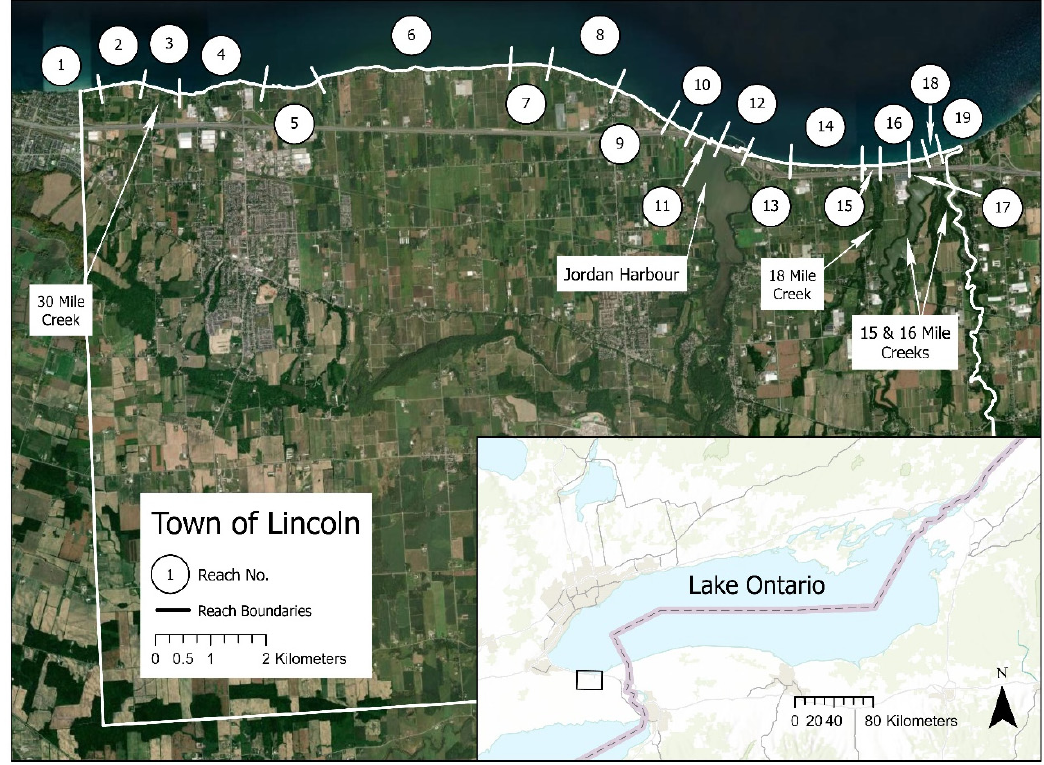
Figure 1. Town of Lincoln location along Lake Ontario with coastline reaches and key hydrological features identified.